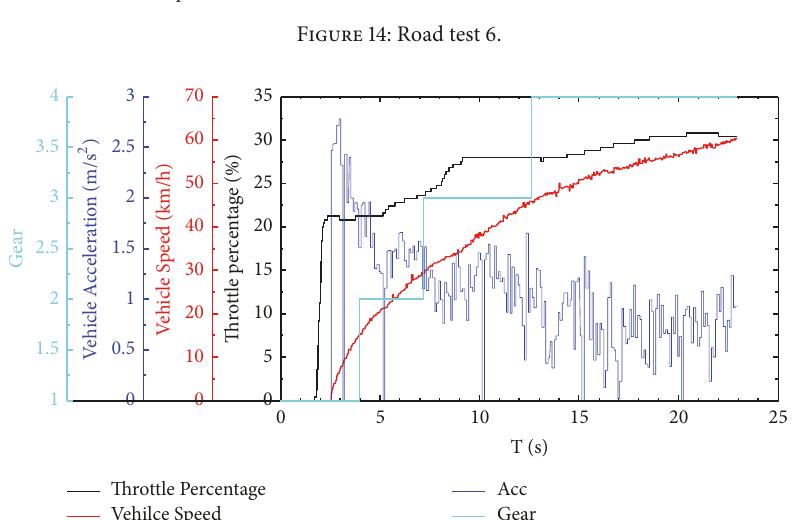
Figure 14: Road test 6.